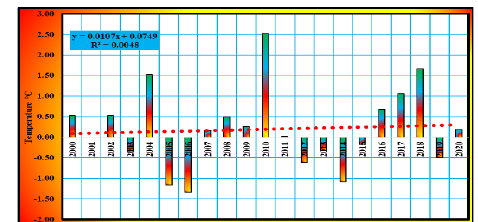
Figure 14: Represents Spring Temperature Deviation in Ghotki district 2000-2020